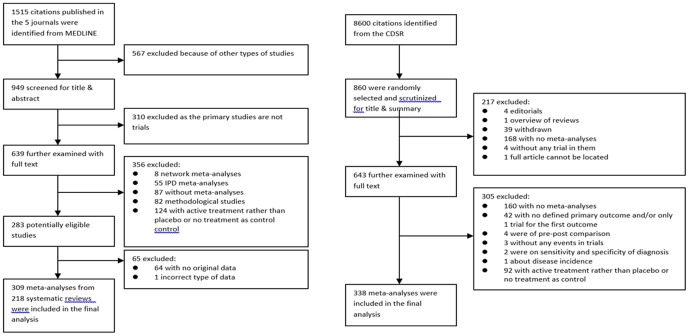
Flow chart of literature search.